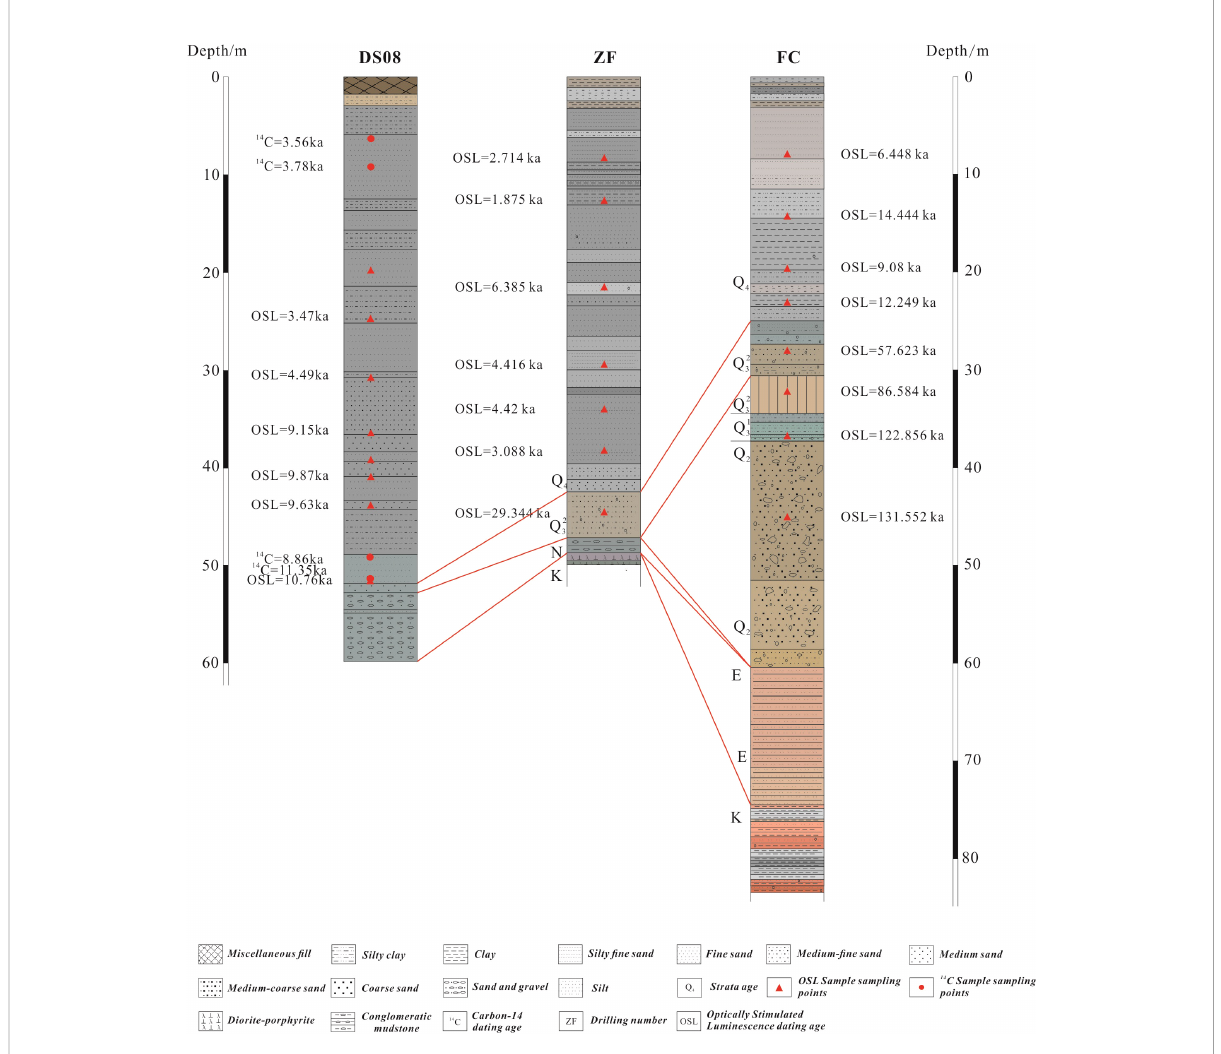
FIGURE 2 Comparison of sedimentary stratigraphic division between ZF, FC and DS08 boreholes (Su et al., 2019) in the study